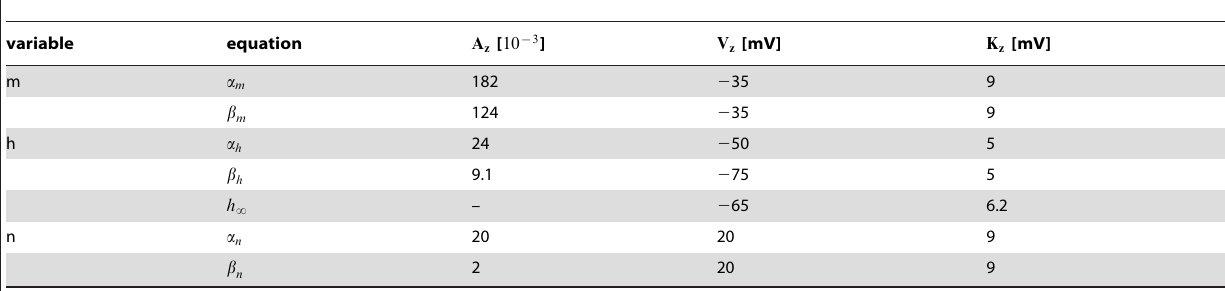
Table 1. Kinetic parameters of the biophysical model.